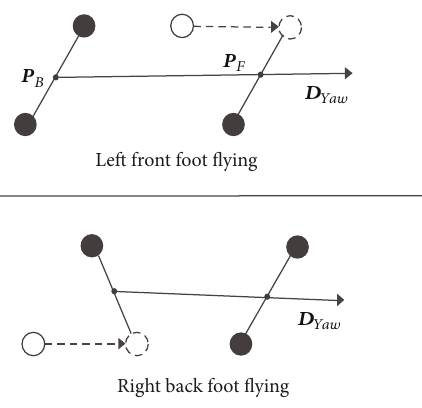
Figure 4: Yaw angle